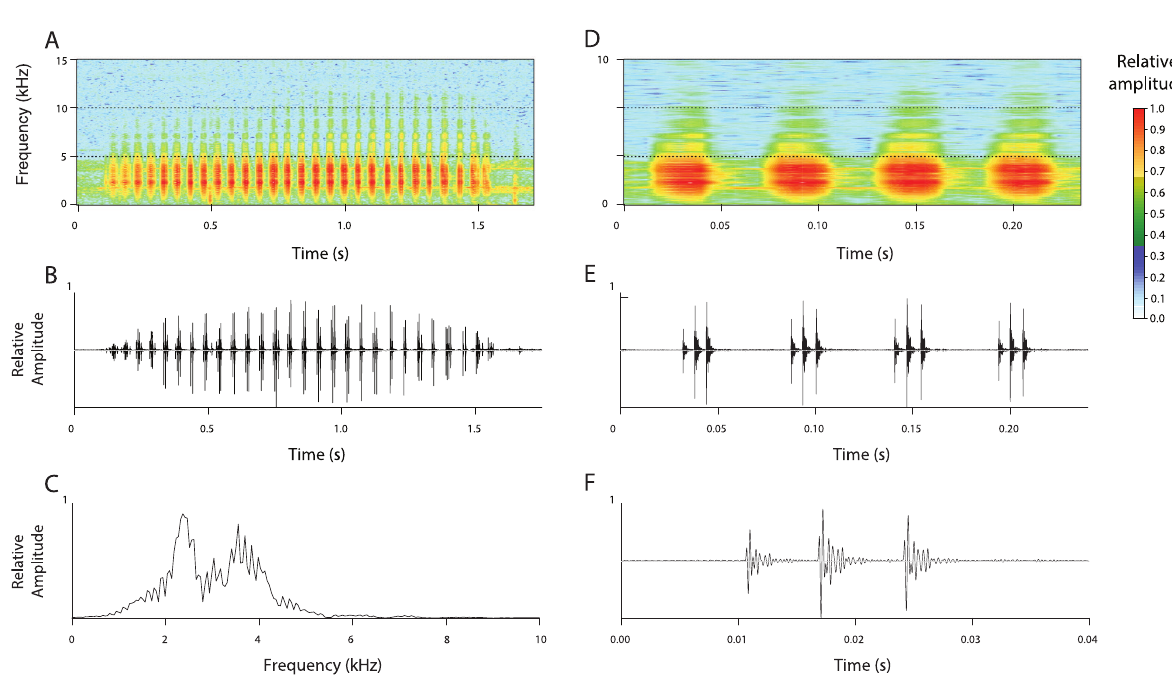
Figure 6. Oscillograms and spectrograms of the call of Gephyromantis marokoroko sp. nov. (Holotype: KU 343230) . A. The entire call spectrogram and B. Entire call oscillogram; C. Power spectra/frequency spectrogram of a single note; D. A close-up spectro- gram of four notes and E. Corresponding oscillogram; and F. an individual note taken from the middle of the